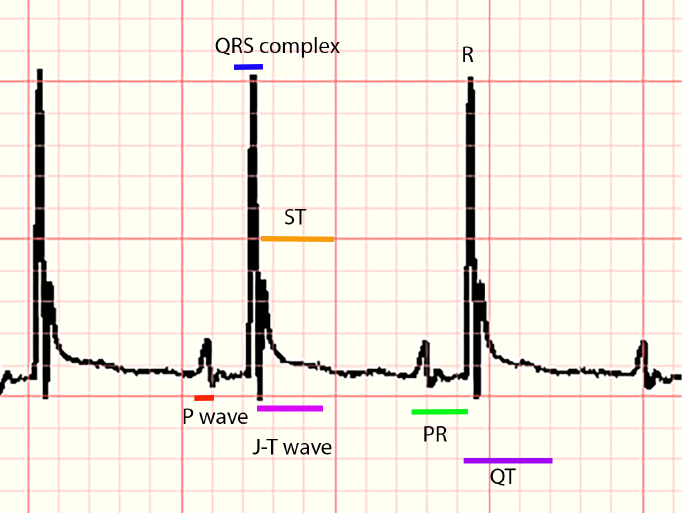
Figure 1. ECG of a healthy mouse. The P wave (atrial depolarization), followed by the QRS complex (ventricular depolarization), the R wave (depolarization of the ventricles), the J wave (early ventricular repolarization), the T wave (ventricular repolarization), the PR interval (time for electrical conduction from the atria to the ventricle), the ST segment (ventricular repolarization), and QT (ventricular depolarization